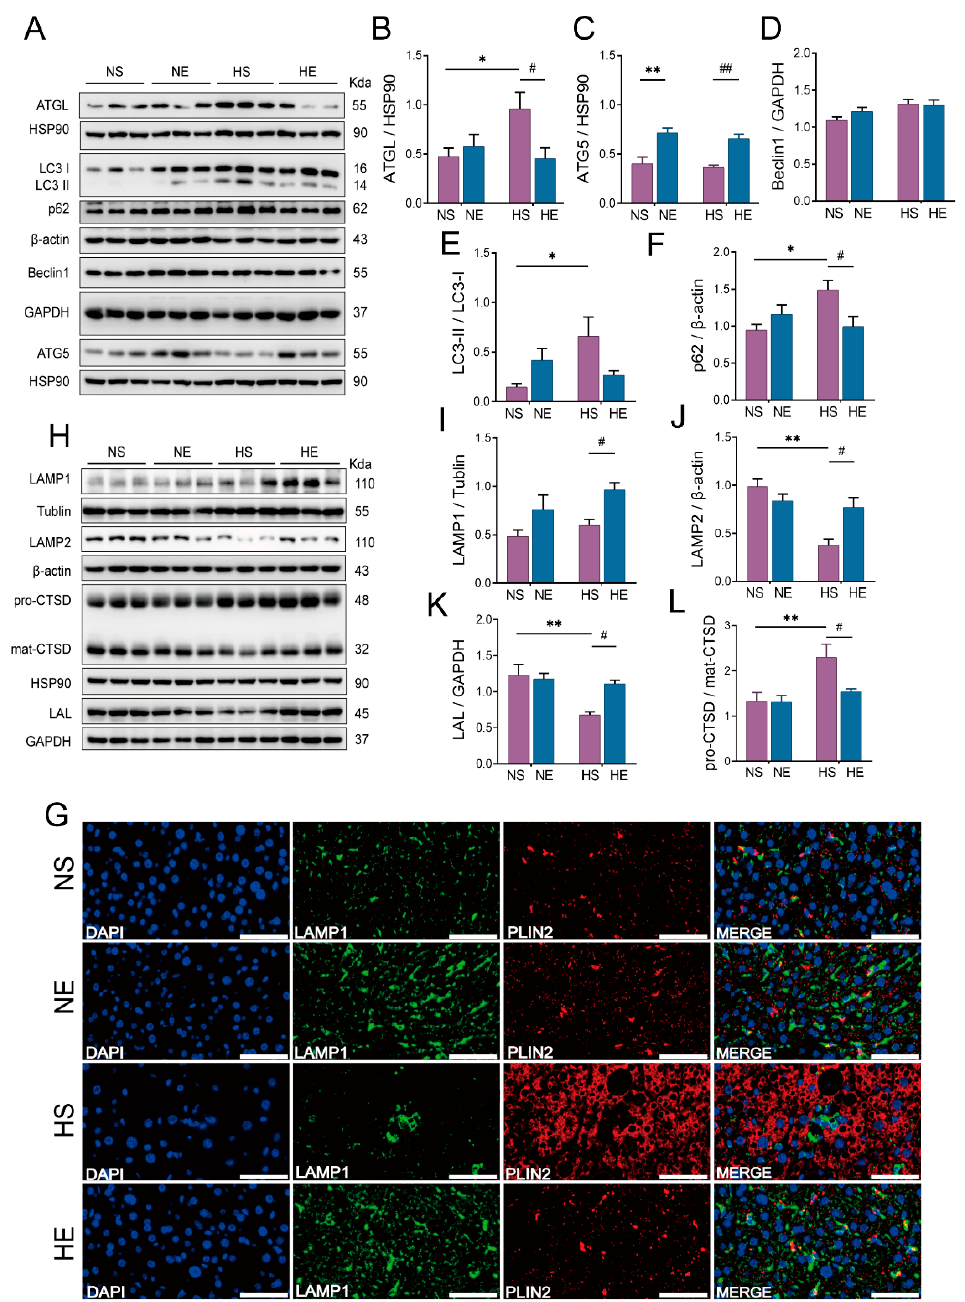
Figure 5. Exercise enhances the degradation of hepatic LDs in lysosomes of HFD mice. ( A – F ) Representative of autophagy-associated proteins immunoblotting and quantified data, including ATGL, Beclin1, LC3B, ATG5, and p62, ( G ) representative of lipophagy-related immunofluorescence by the colocalization of PLIN2 and LAMP1 in the liver (scar bar: 50 um, n = 3), ( H – L ) representative of lipophagy-associated lysosomal proteins immunoblotting and quantified data, including LAMP1, LAMP2, LAL, and CTSD. Unless otherwise specified, six mice per group were used in each experiment. The data are expressed as mean ± SEM. * p < 0.05, ** p < 0.01 versus NS mice; # p < 0.05, ## p < 0.01 versus HS